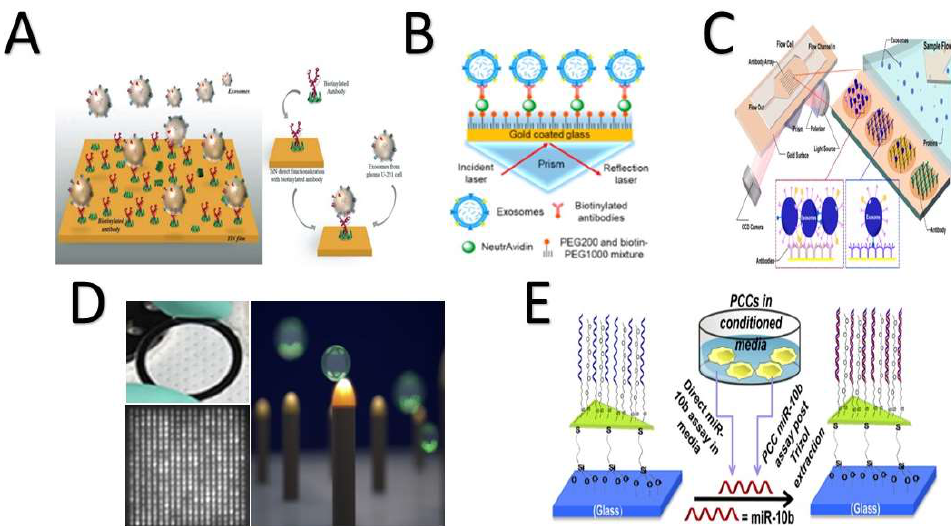
Figure 5. Examples of surface plasmonic biosensors for exosome detection and quantification. The figure permissions are as follows: ( A ) License number 5071041050010, license date 16 May 2021,